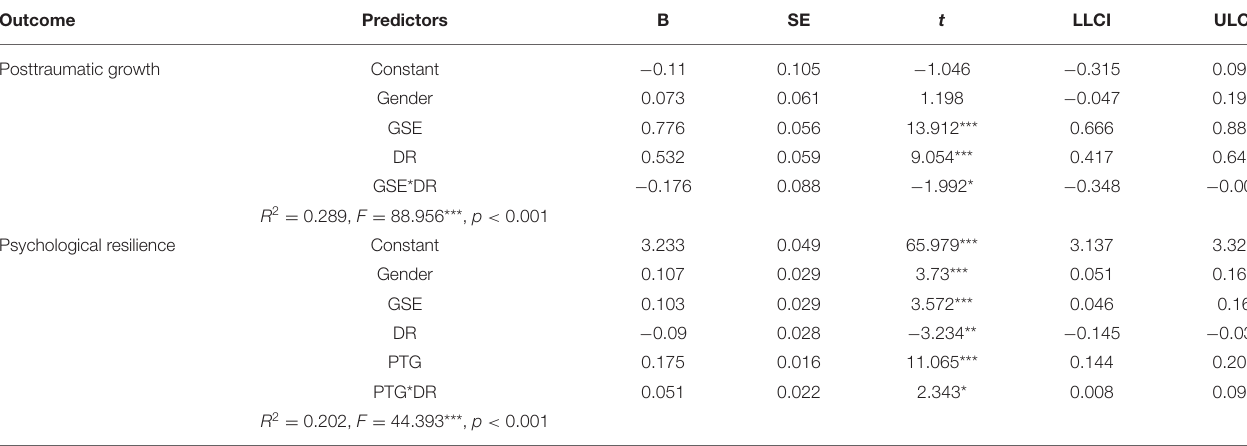
TABLE 4 | Regression results for moderation analysis ( N = 881). Outcome